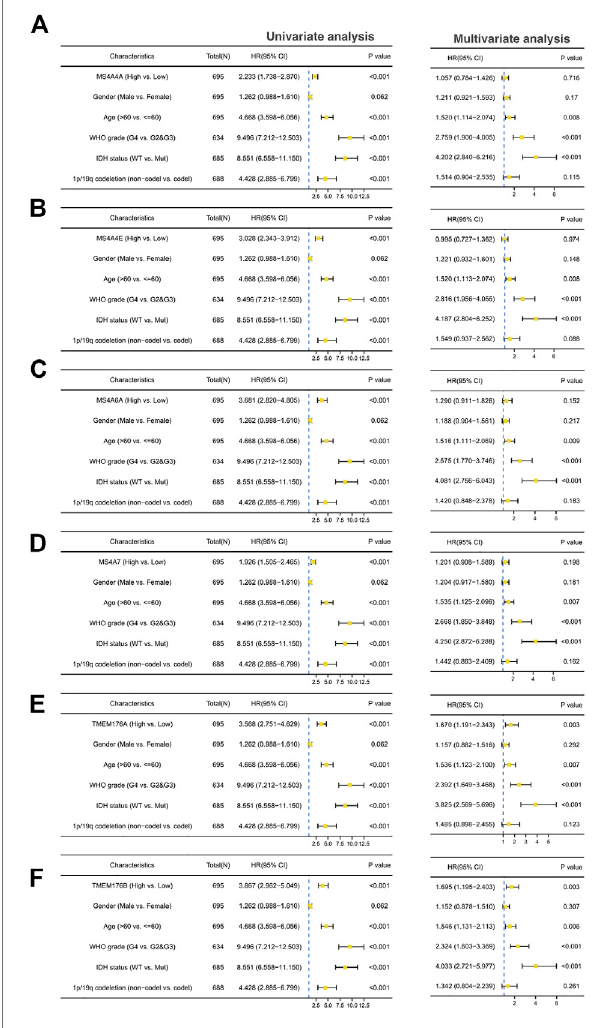
FIGURE 4 | Univariate and multivariate Cox prognostic analyses of the correlation between MS4A expression with clinical – pathological factors [ (A) MS4A4A; (B) MS4A4E; (C) MS4A6A; (D) MS4A7; (E) TMEM176A; and (F)